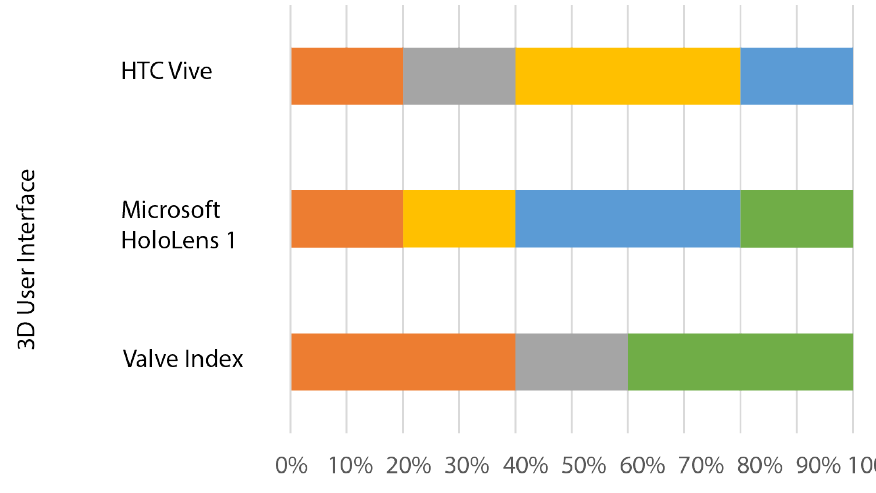
Figure 6. Response distribution associated with perceived task difficulty associated with the con- troller input when locating the eye funds anatomical